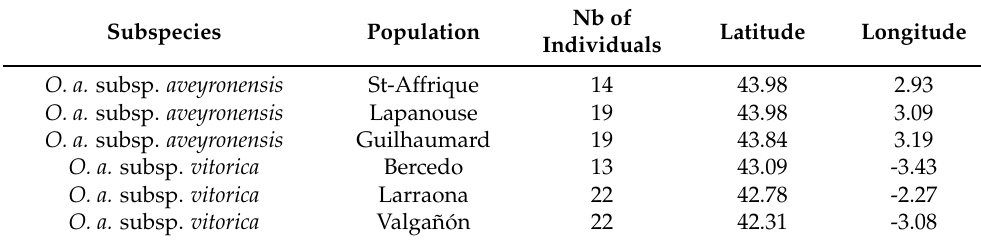
Table A1. Summary table of individuals and populations sampled for each subspecies of O. aveyronensis.